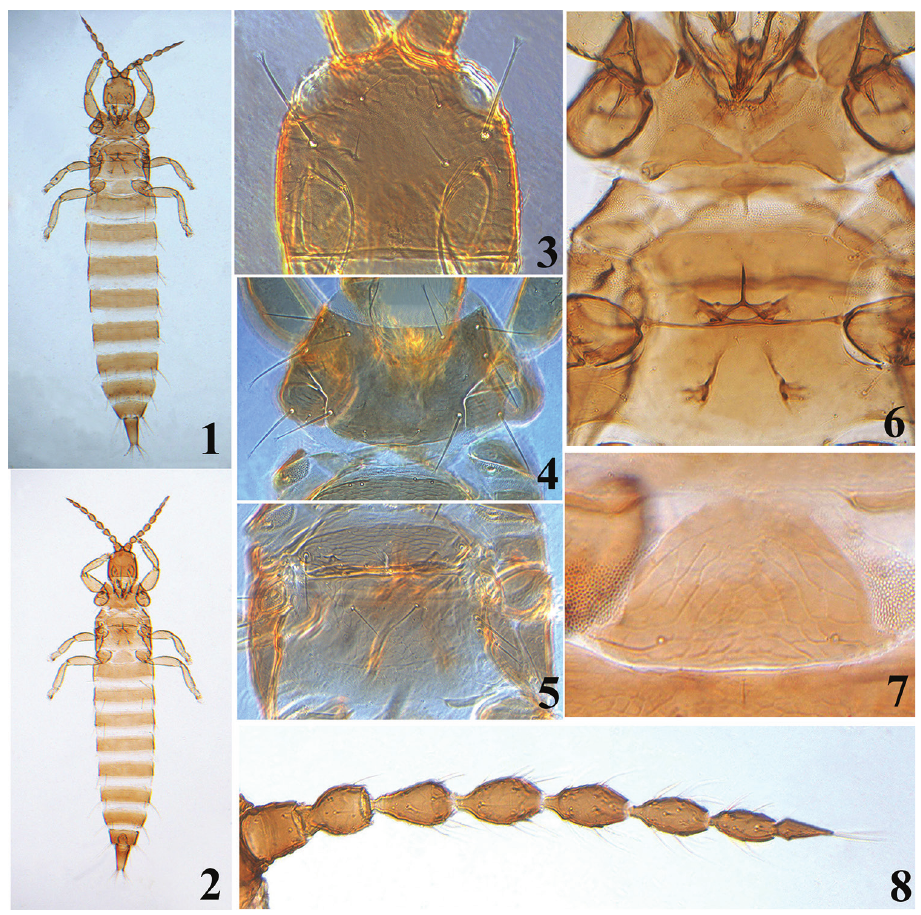
6 ventral view of thorax 7 pelta 8 antenna. Pronotum dorsal surface almost smooth but with faint transverse lines anteriorly; no- topleural sutures complete; five pairs of major setae long and expanded (Fig. 4). Basantra present but small; ferna and prospinasternum well-developed. Mesonotum sculptured with distinctly transverse reticulation, and a pair of well-developed long lateral setae ex- panded at apex; mesopresternum eroded medially, divided into two small irregular lateral plates. Metanotum weakly sculptured with polygonal reticulation, a pair of long and acute setae situated medially (Fig. 5); meso- and metasternum smooth; metathoracic sterno- pleural sutures absent (Fig. 6); mesoeusternum anterior margin entire, mesothoracic fur- cae united together medially, but metathoracic furcae separated. Fore tarsal tooth absent. Pelta nearly semicircular in shape with short lateral lobes, distinctly reticulate, a pair of campaniform sensilla present (Fig. 7); abdominal tergites weakly sculptured with reticulation, without developed sigmoid wing retaining setae; S1 and S2 setae